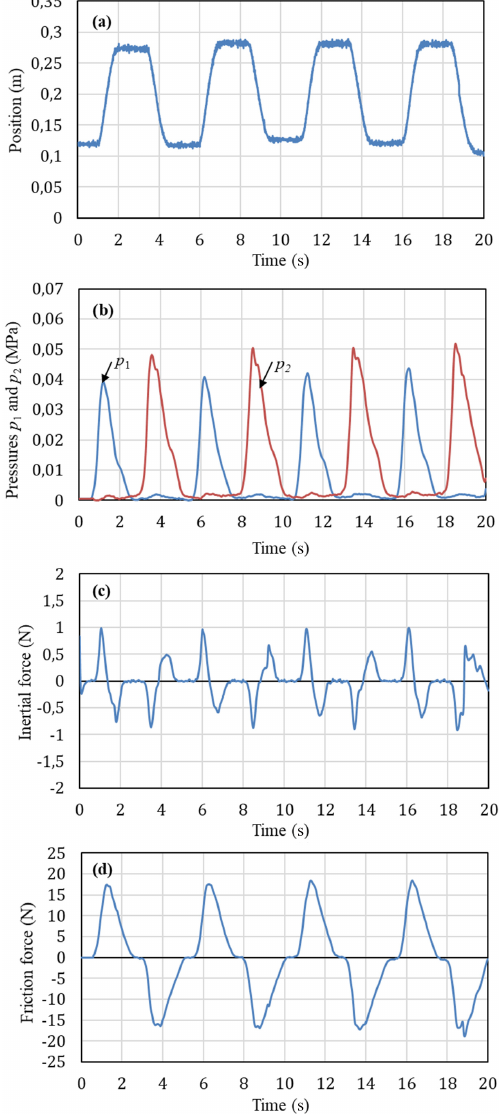
Figure 8. Experimental characteristics at operating conditions of u 1 = 2 . 99V, u 2 = 2 . 09V and M = 1 . 3kg: (a) piston position, (b) pressures in the cylinder chambers, (c) initial force, (d) friction force.